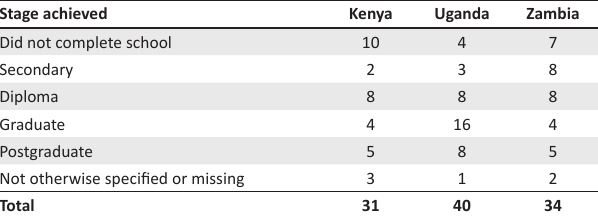
TABLE 2: Highest educational level of study participants. Stage